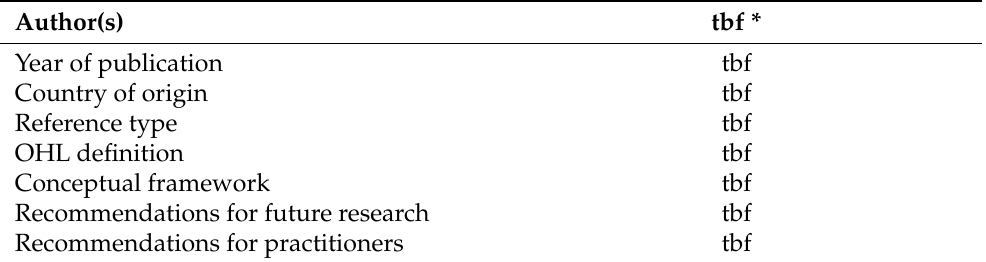
Table 4. Example of data extraction sheet, RQ1.